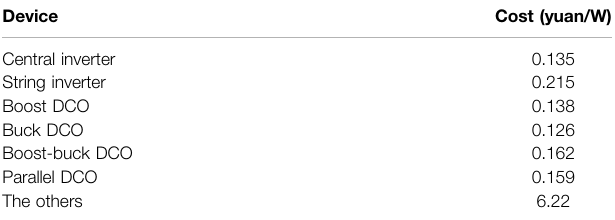
TABLE 3 | Investment costs per unit of capacity for the components of PV plants.